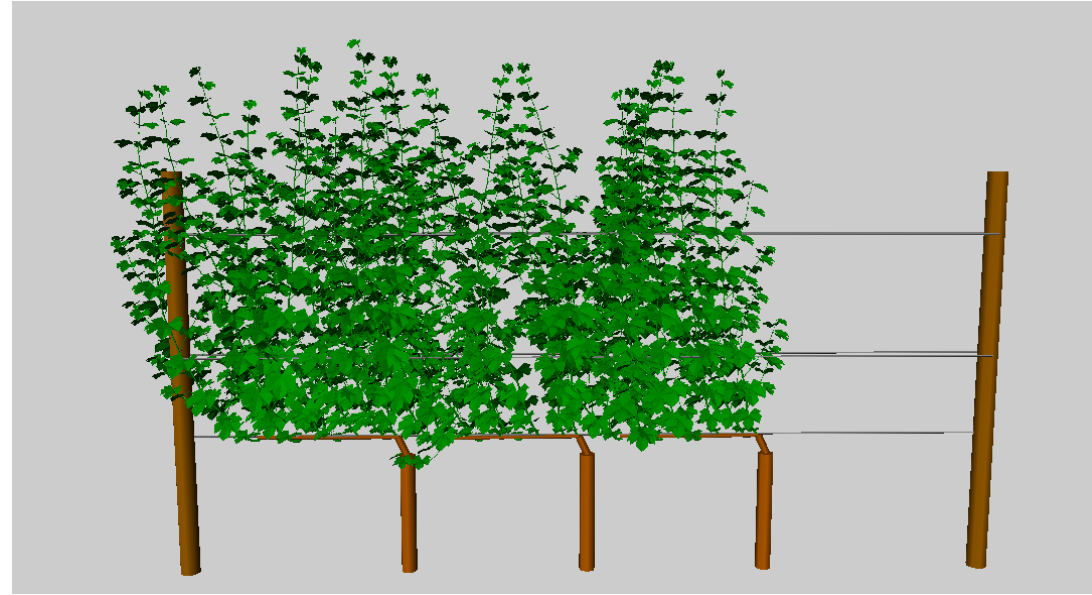
Figure 8. Exemplary end-of-simulation plant architecture including the scene of the Virtual Riesling vineyard section consisting of three plants between two posts and the shoot positioning wire